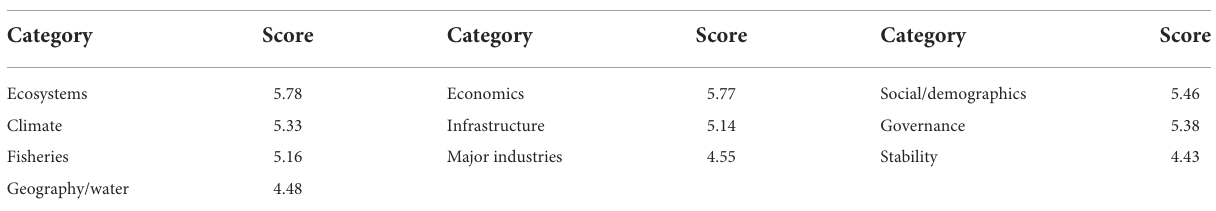
TABLE 4 Kingston risk profile